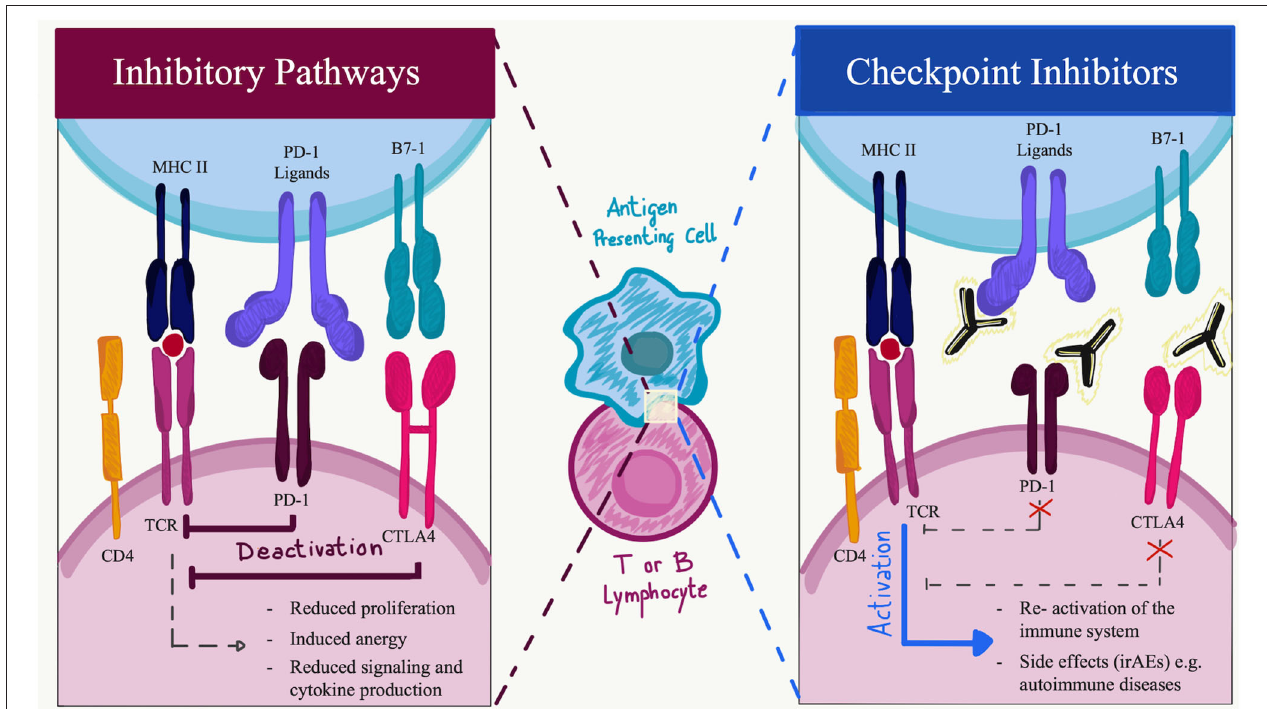
FIGURE 1 | Immune checkpoint function during activation or inhibition pathways. Made with Adobe